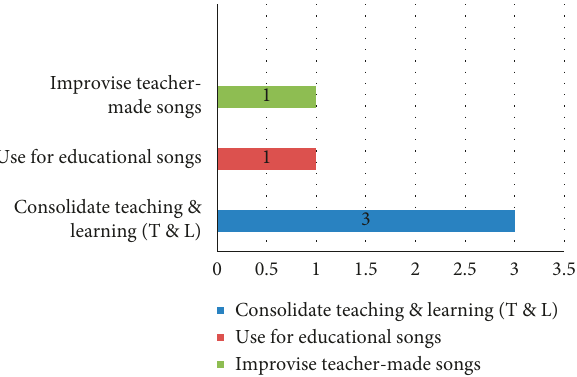
Figure 3: Number of teachers who use YouTube for various